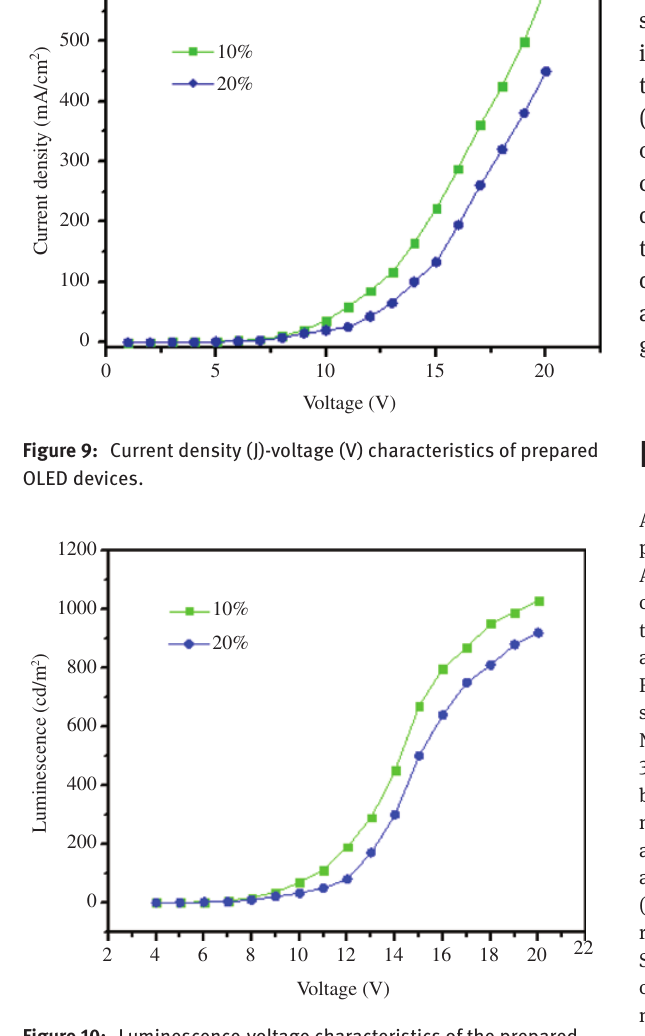
Figure 10: Luminescence-voltage characteristics of the prepared OLED